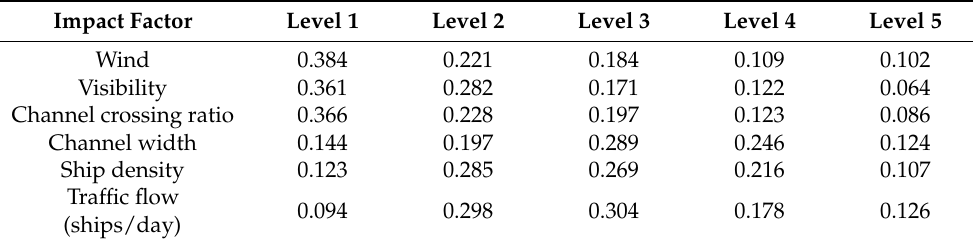
Table 4. The probability of natural occurrence of navigational environment at different levels.